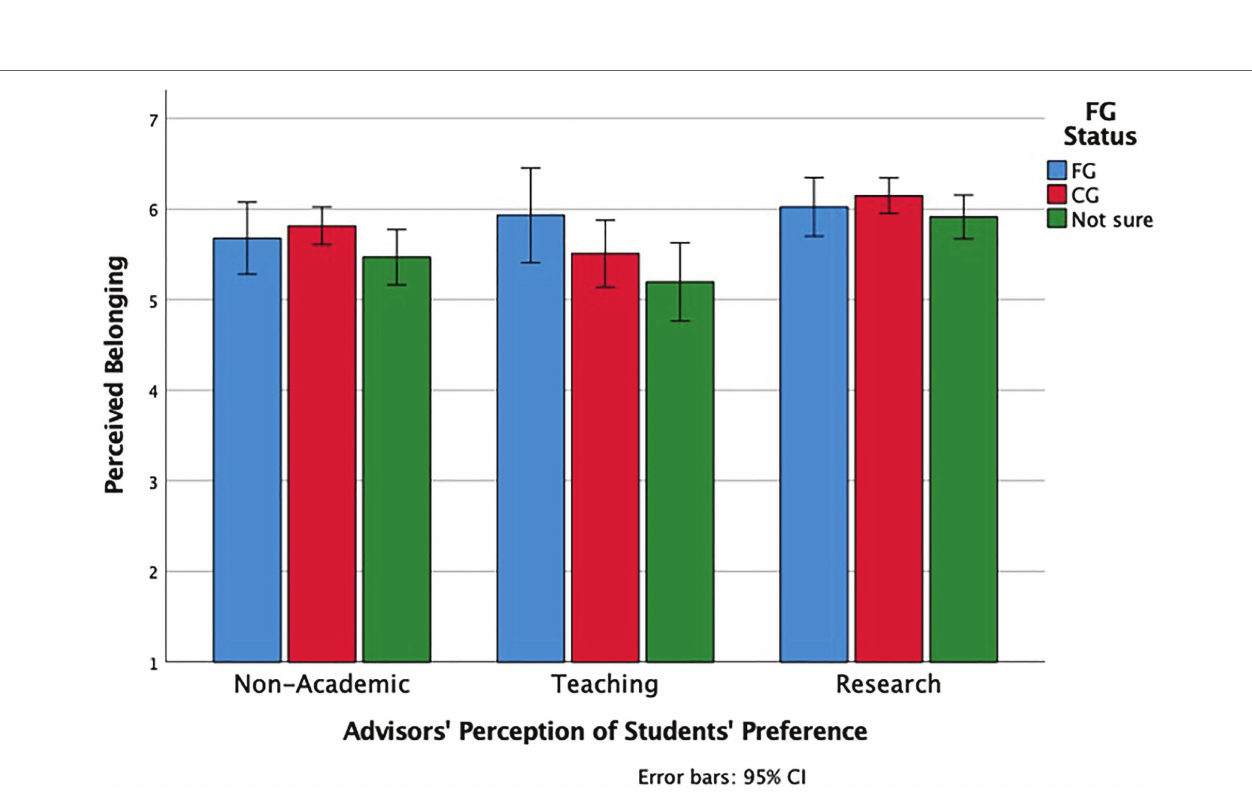
FIGURE 6 | Advisors’ perception of their students’ sense of belonging, as a function of URM status and their perception of students’ career preference.